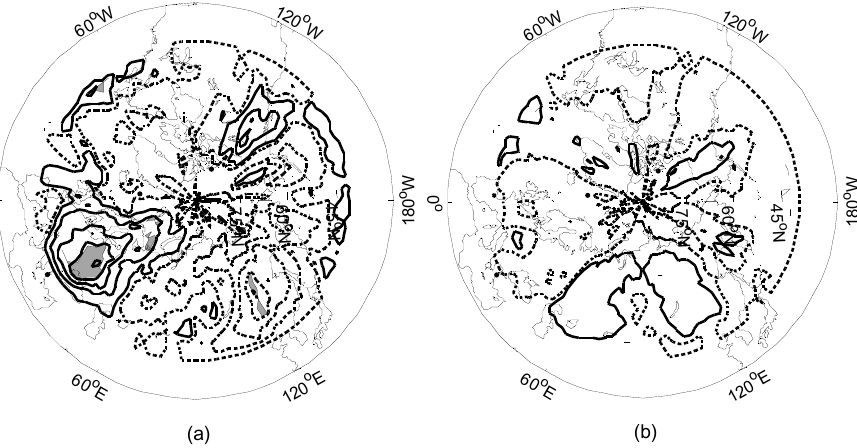
Figure 12. Composites of the blocking frequency anomalies for extreme precipitation years ( a ) and normal precipitation years ( b ). The contour interval is 2; shading denotes the 95% confidence level.